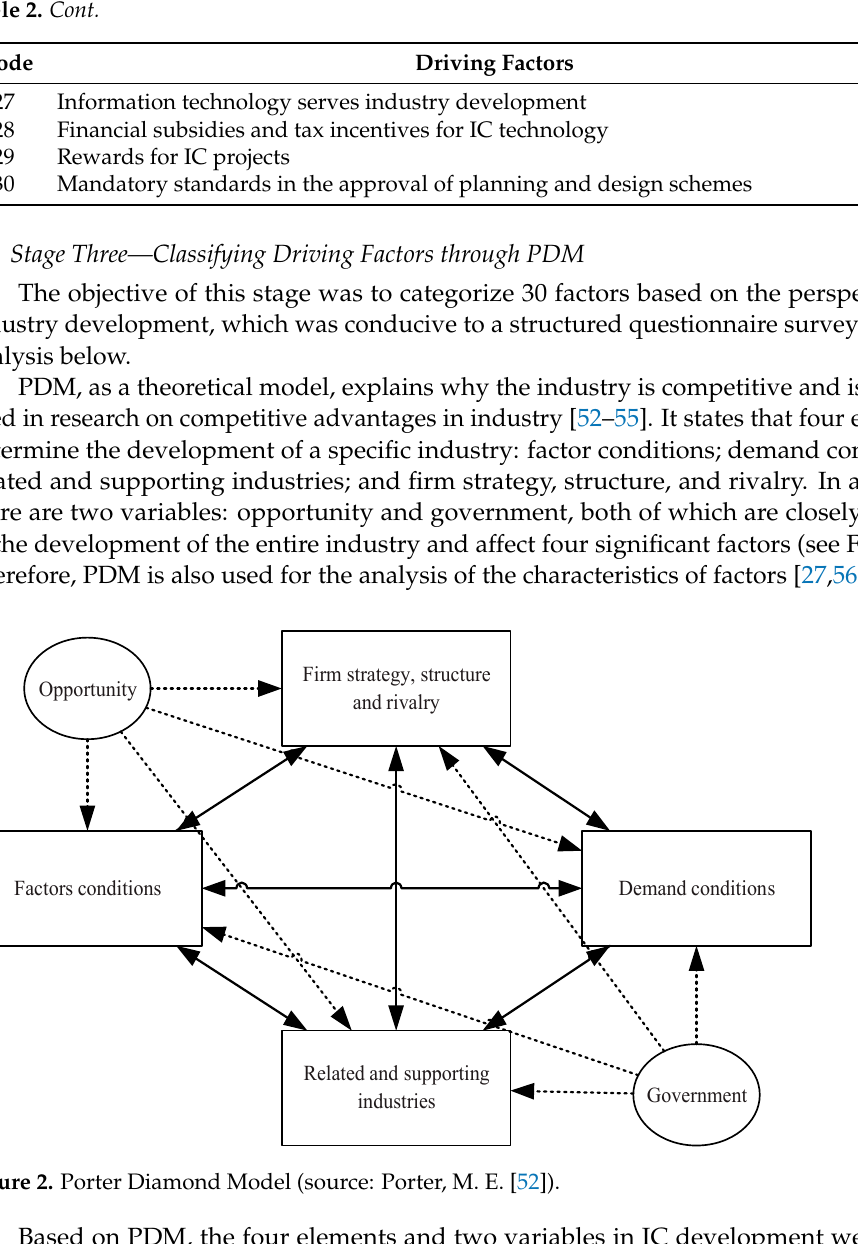
Table 3. Classification of driving factors for the development of IC.